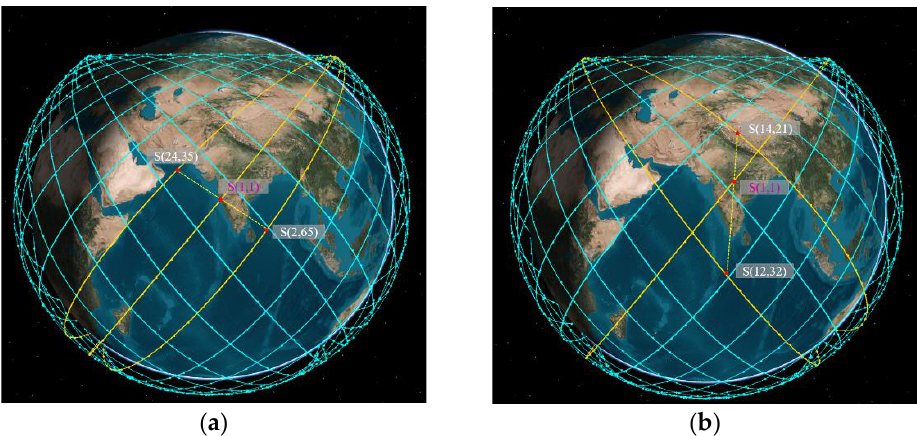
Figure 2. This is the schematic diagram of heterodyne LISLs. ( a ) Adjacent and nearby OP LISLs; ( b ) Crossing OP LISLs.